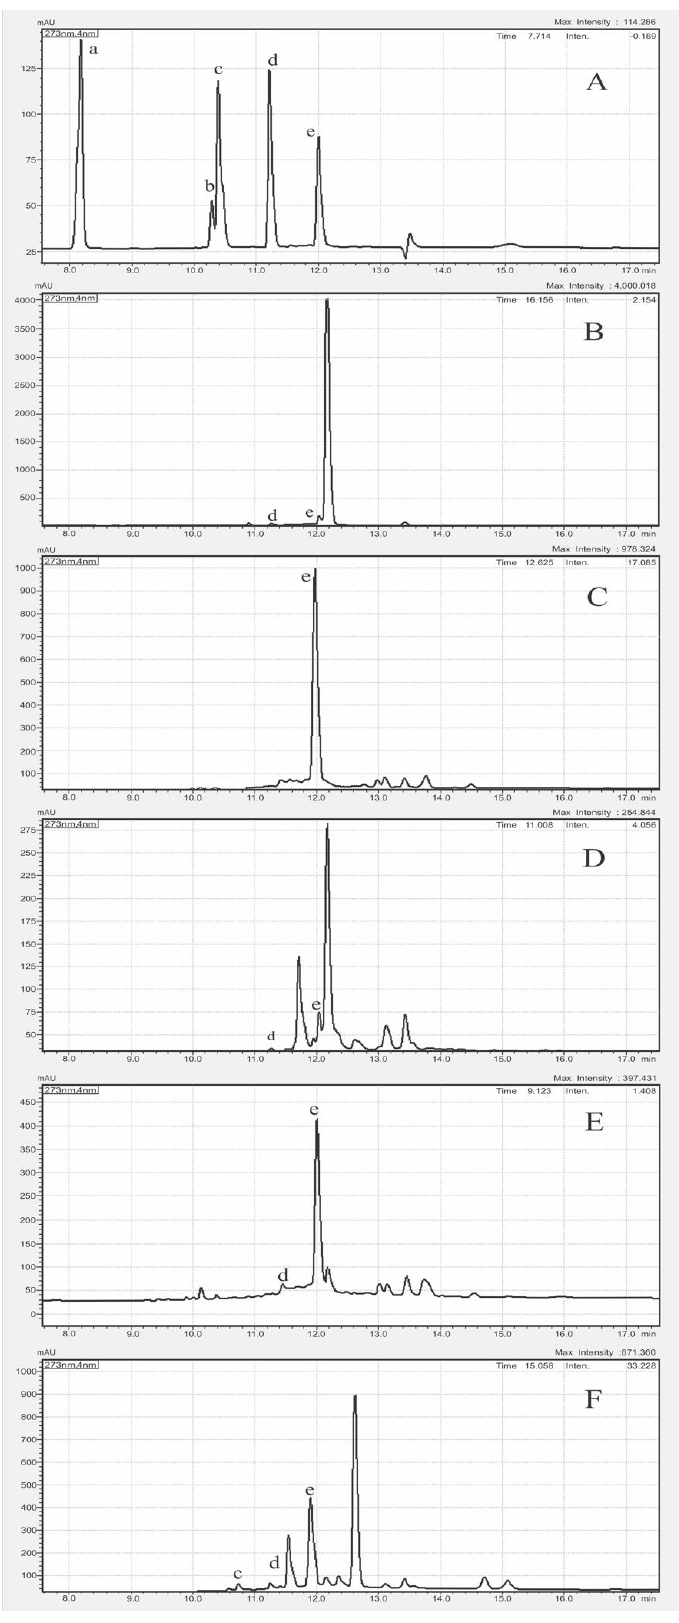
Figure 5. HPLC-PDA chromatograms of ( A ) five SPC standard solutions, ( B ) K. galangal , ( C ) C. longa , ( D ) A. purpurata , ( E ) C. xanthorrhiza. , and ( F ) B. rotunda . (a: gallic acid, b: naringin, c: ferulic acid, d: quercetin, e: